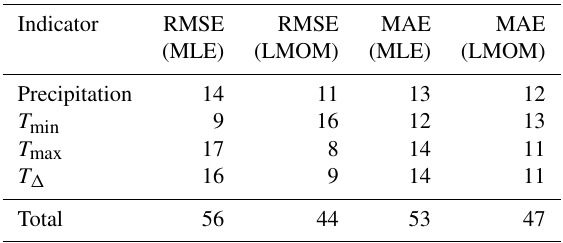
Table 2. Comparison of parameter estimation methods for the PDS approach based on goodness-of-fit measures RMSE and MAE. Numbers indicate success cases of MLE and